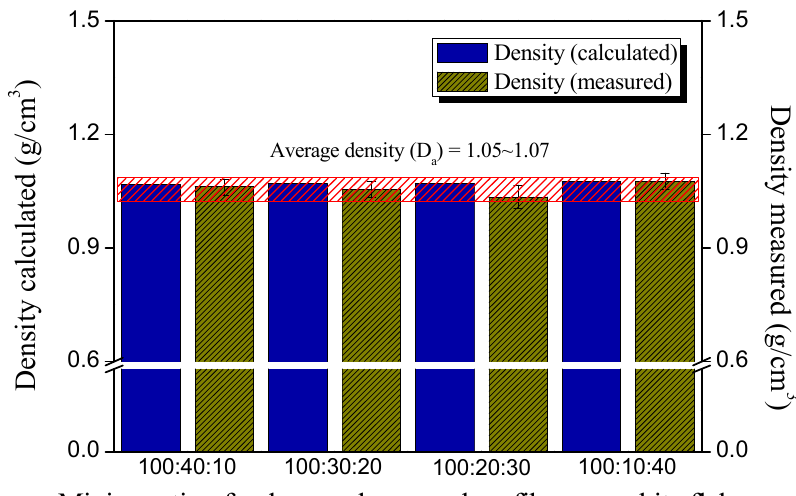
Figure 1. Calculated and measured densities of the composites with different mixing ratios of polypropylene:carbon fibers:graphite flake.